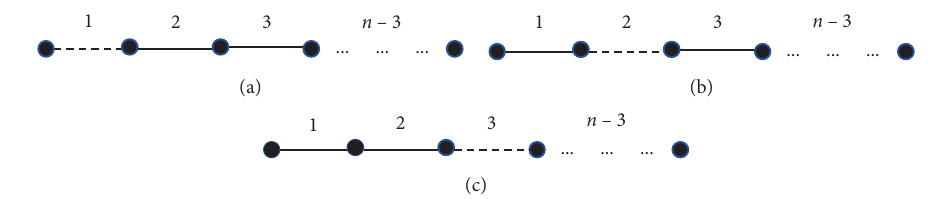
Figure 1: Operational state diagram for a bus